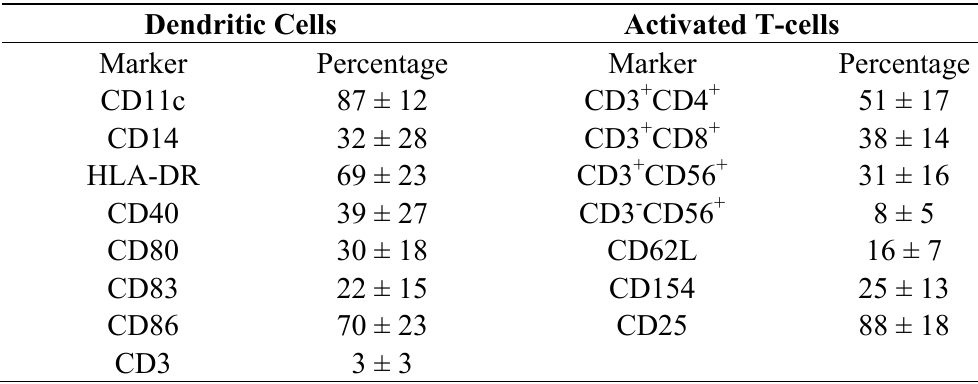
Table 1. Phenotypic characteristics of cell